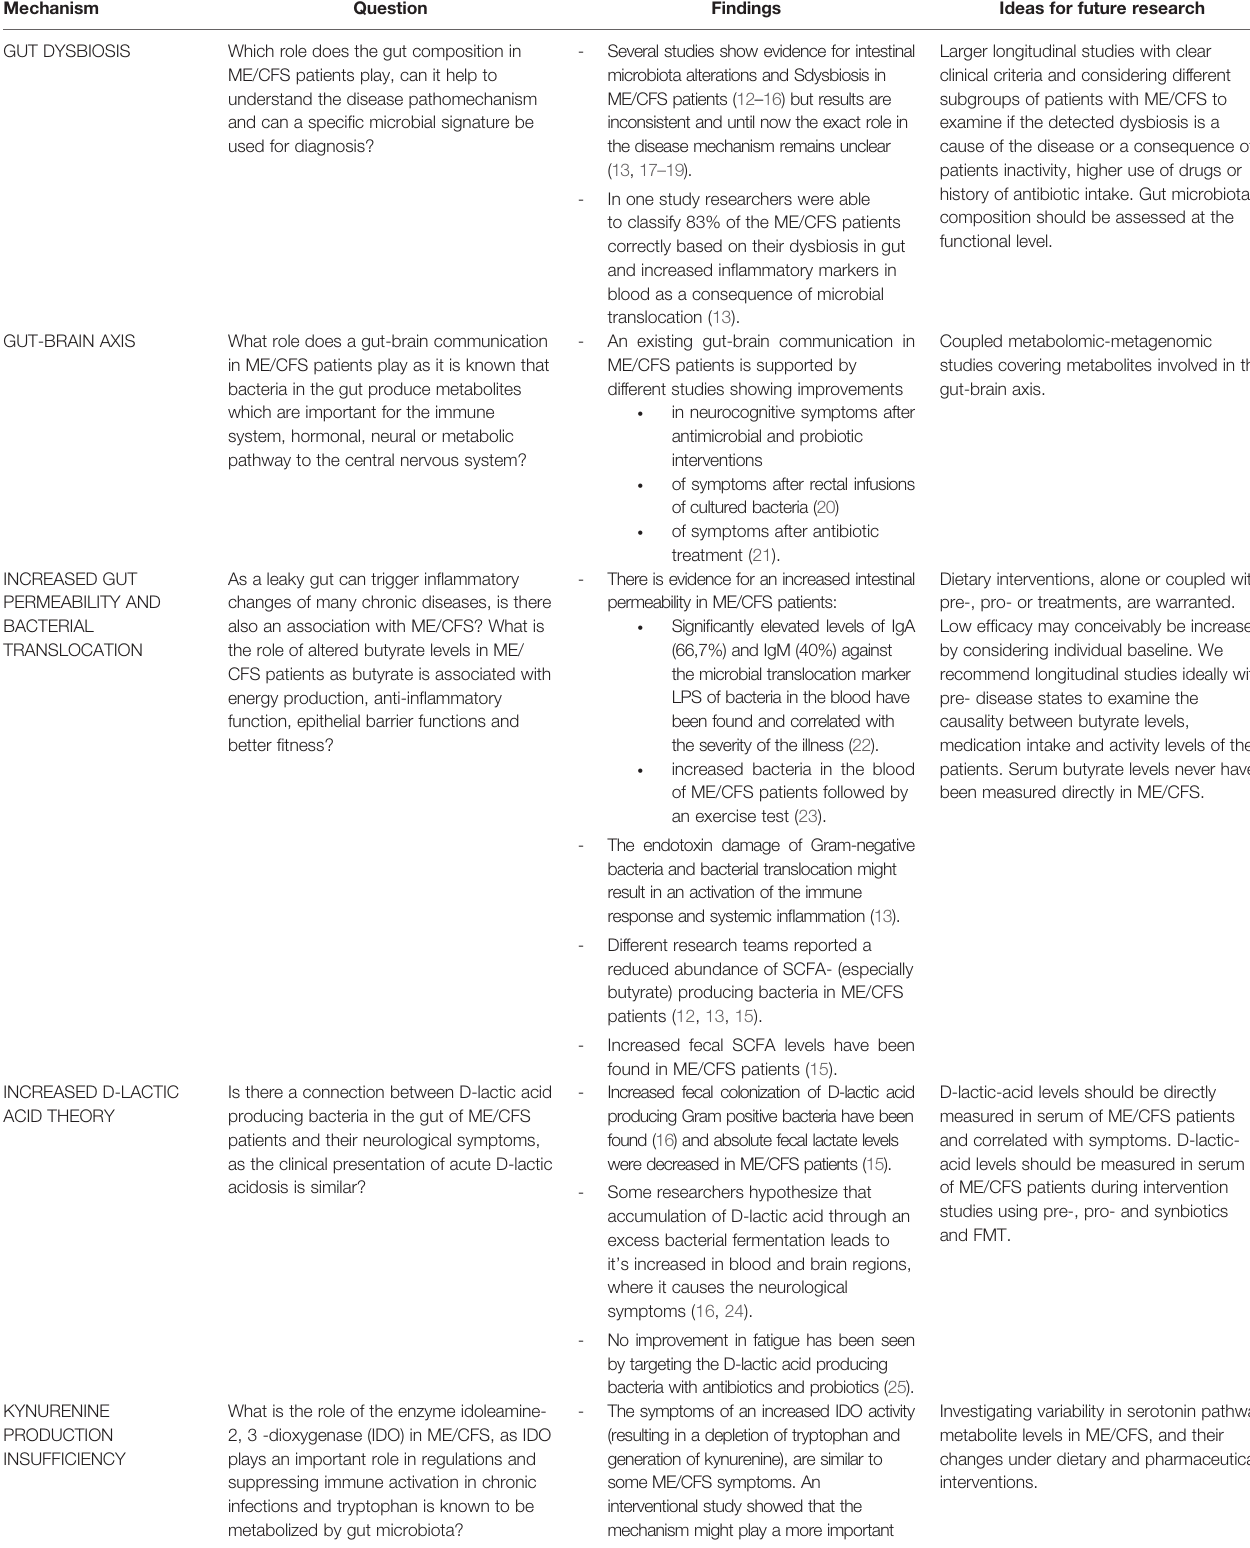
TABLE 1 | Overview of Results with the theories of possible pathomechanisms concerning the microbiome in ME/CFS.